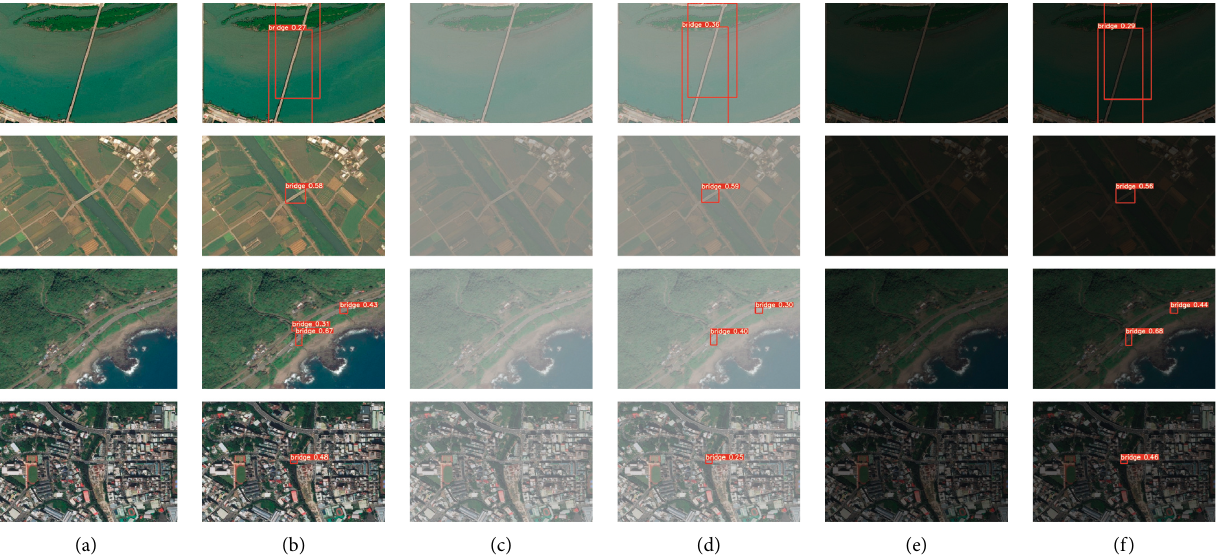
Figure 12: The comparisons of YOLOv3 network under normal, hazy, and low-light imaging conditions. (a) Original. (b) Origi- nal+YOLOv3. (c) Hazy. (d) Hay+YOLOv3. (e) Low-light. (f) Low-light